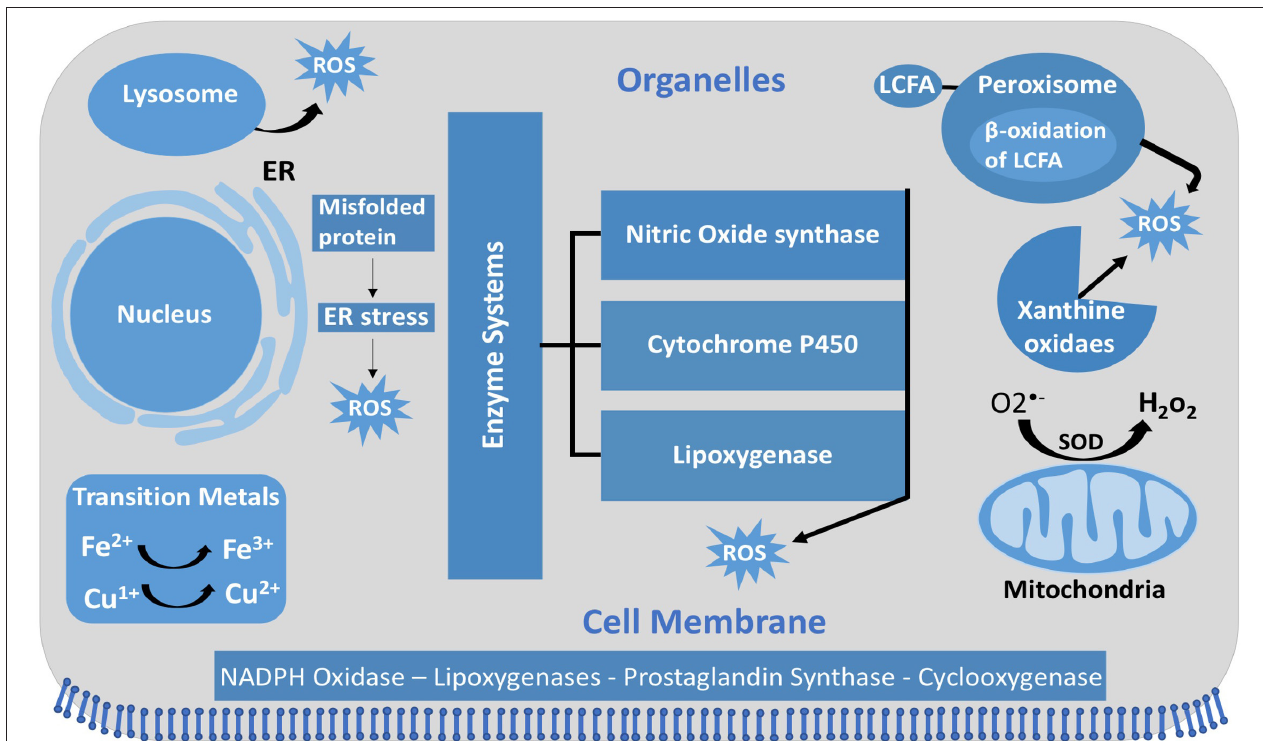
FIGURE 1 | Intracellular ROS and their sources and localization in EC. In addition to NOX, intracellular sources of ROS include lysosome, ER, peroxisome, and mitochondria. SOD, superoxide dismutase; GSH, glutathione; ER, endoplasmic reticulum; LCFA, long-chain fatty